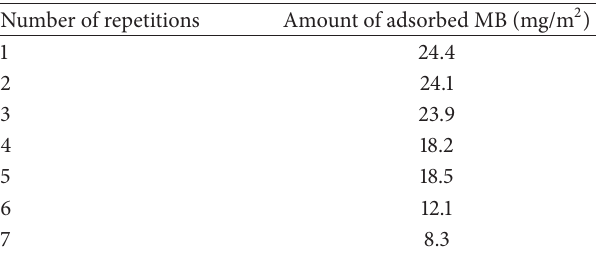
Figure 7: Decolorization of MB as a function of 𝑡 30 w (illumination time) on TiO 2 /PET surface at different repetitions. Table1:TheinitialamountofadsorbedMBmoleculesonTiO 2 /PET sheets at different repetitions.